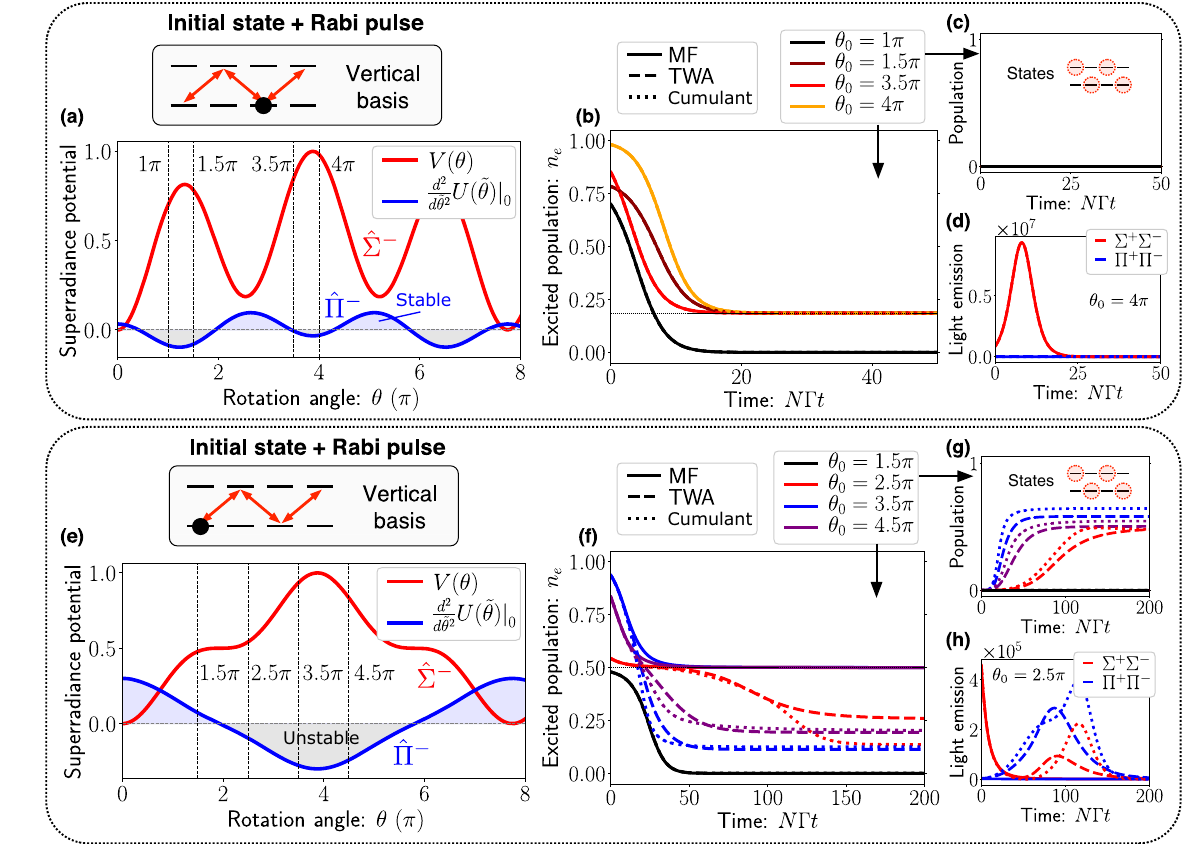
3 = 2 starting in the (upper F FIG. 10. Two-polarization superradiance and dark states. Results for the eight-level system with F g ¼ e ¼ ˆ Σ (cid:2) or (lower panel) j g − 3 states and being initially excited by a drive. This drive creates an initial superposition panel) j g 1 = 2 i V = 2 i V , j g 1 , j e − 1 , and j e 3 states that are connected in a zigzag fashion. In (a) and (e) we show the superradiance between the j g − 3 = 2 i V = 2 i V = 2 i V = 2 i V ˜ θ 2 ˜ θ ˆ Σ − ˆ Π − potential V ð θ Þ (red) for decay and the curvature of the orthogonal potential ð d 2 =d (blue) for decay as a function of the Þ U ð Þj ˜ θ ¼ 0 ˆ Π − decay. The (b) – (d) and (f) – (h) initial rotation angle θ ¼ θ 0 . The blue (black) shaded regions denote states that are stable (unstable) to plots show results for different values of θ 0 (color lines) obtained with MF (solid), TWA (dashed), and cumulant (dotted) simulations for P 1 =N Þ N ¼ 10 4 : (b) and (f) show the excited-state population n h ˆ σ q e i as a function of the time N Γ t , (c) and (g) show the e ¼ ð m m e m , j g 3 , j e − 3 , and j e 1 states, and (d) and (h) show the light emission intensity in both combined population of the j g − 1 = 2 i V = 2 i V = 2 i V = 2 i V ˆ Σ þ ˆ Σ − ˆ Π þ ˆ Π − polarizations, h i (red) and h i (blue), for (d) θ 0 ¼ 4 π and (h) θ 0 ¼ 2 . 5 π . The thin dotted black lines in (b) and (f) denote the position of the MF stationary points predicted by V ð θ Þ . Note that whenever dashed and dotted lines are not visible [e.g., in (b) – (d) and for θ 0 ¼ 1 . 5 π in (f) – (g)], they lie on top of the solid lines of the same color; i.e., all methods